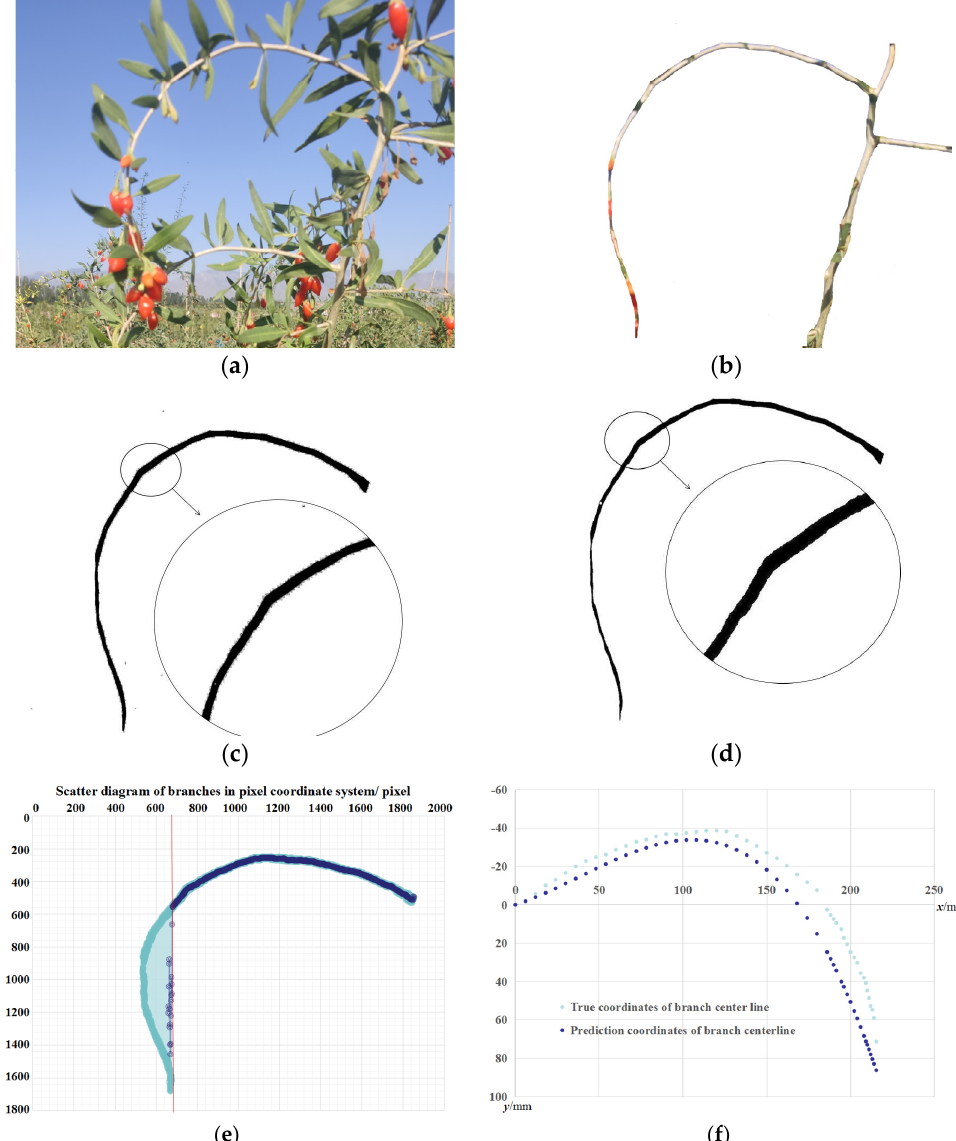
Figure 9. Image processing of branches: ( a ) original image; ( b ) manually remove the target area; ( c ) binary diagram; ( d ) morphological operation; ( e ) scatter diagram of 50 points on the branch centerline in the picture pixel coordinate system; ( f ) scatter diagram of 50 points on the centerline of real branches and predicted branches in the branch coordinate